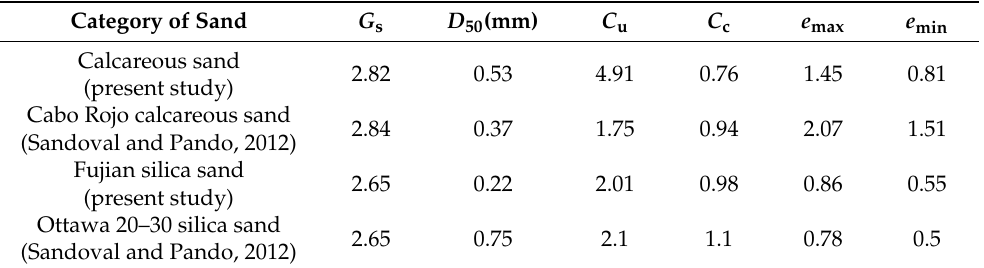
Table 2. Test conditions and results.